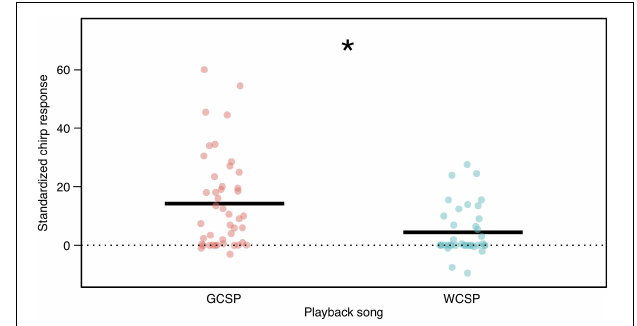
FIGURE 2 | Response of golden-crowned sparrow nestlings to playbacks of conspecific (left) and white-crowned sparrow (right) songs (mean responses represented by horizontal bold lines). To better visualize responses, here the number of chirps in the 1-min pre-playback period was doubled and subtracted from the number of chirps during the 2-min playback period. Statistically, the effect of pre-trial chirping was accounted for by adding it as a fixed effect to the mixed-effects model (see section “Materials and Methods”). The nestling response to conspecific, golden-crowned sparrow songs was significantly higher than to white-crowned sparrow songs ( P = 0.0007) as indicated by an asterisk.